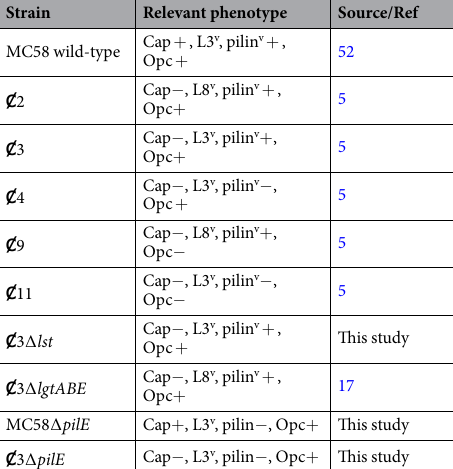
Table 1. Strains used in this study. v = natural phase variant. All strains used in this study are natural LOS variants. Non-encapsulated mutants were created by insertion of an erythromycin cassette into the polysialyltransferase gene ( siaD ) 5 . Opc mutants were created by insertion of an kanamycin cassette into the Opc gene 5 . Strains MC58 ∆ pilE and Ȼ 3 ∆ pilE are pilE knockout mutants created by transformation of MC58 and Ȼ 3, respectively, with a pilE construct from N. meningitidis C311 #3 that has a kanamycin resistance cassette in pilE 45 .